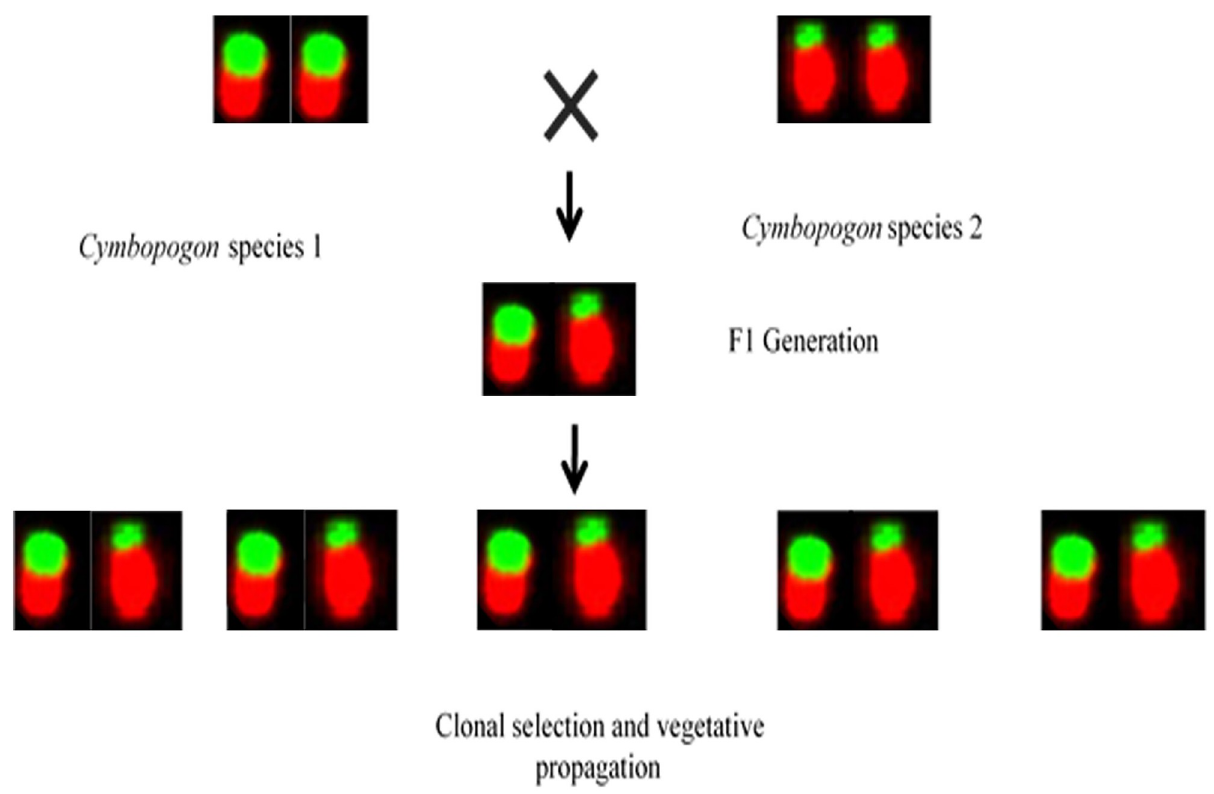
Fig 3. Evolutionary speciation in C . winterianus .